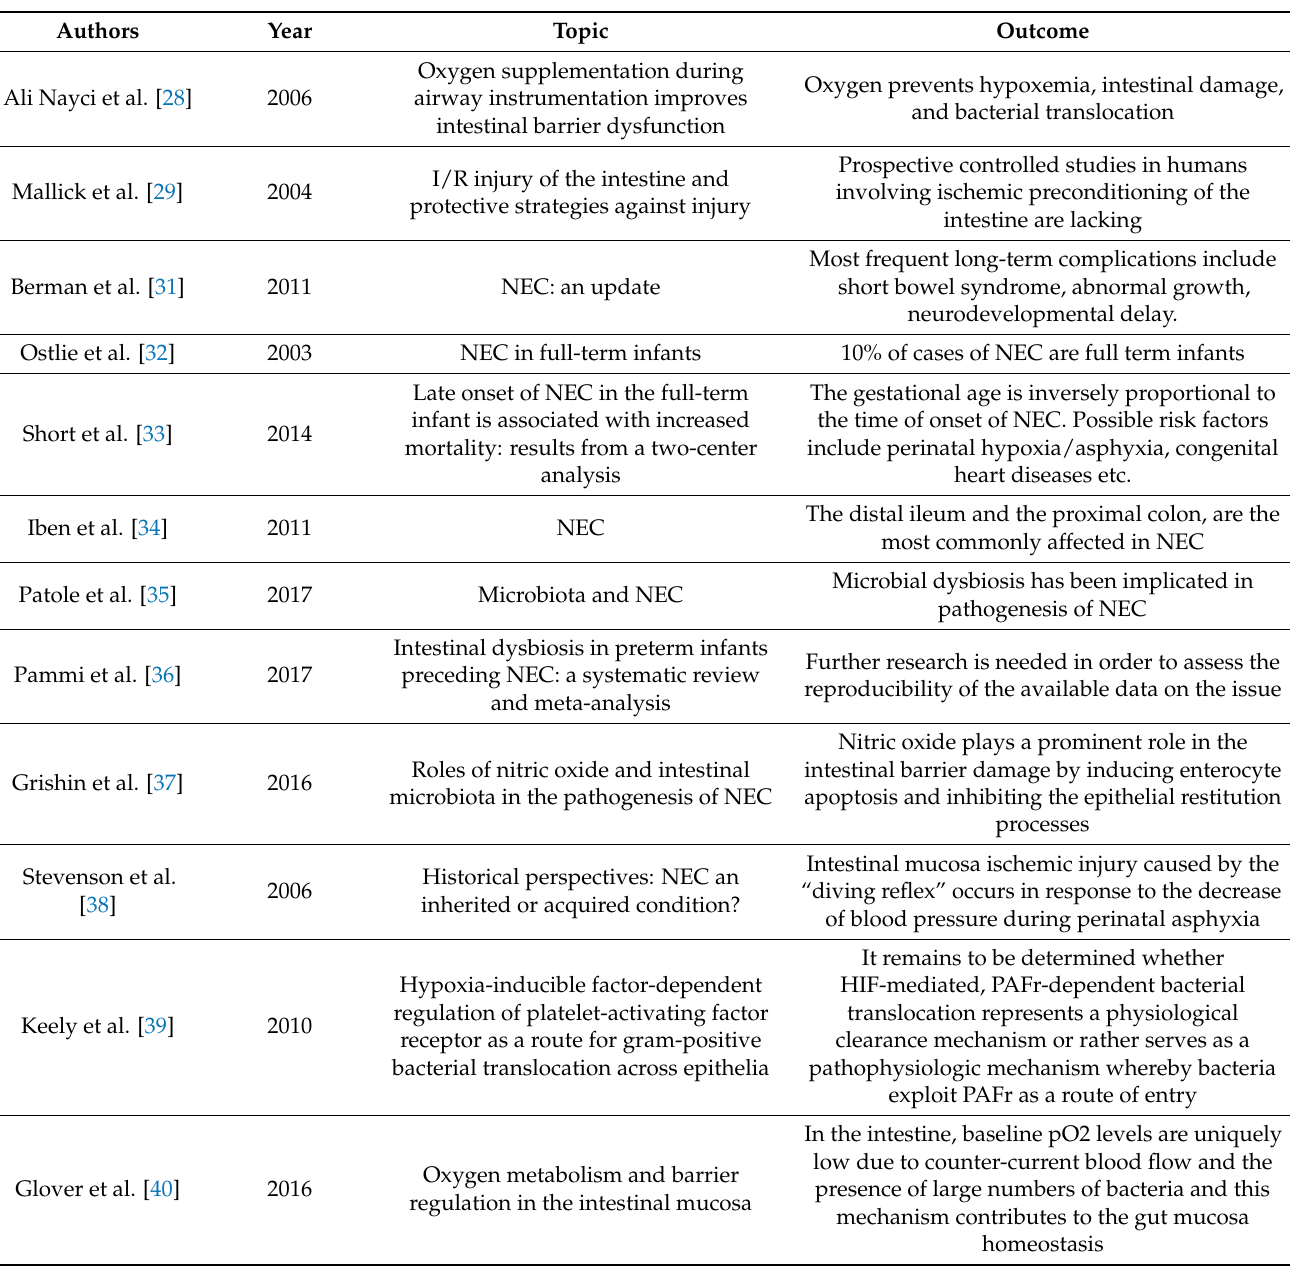
Table 4. The relationship between gut microbiota, intestinal barrier function and microbial transloca- tion and necrotizing